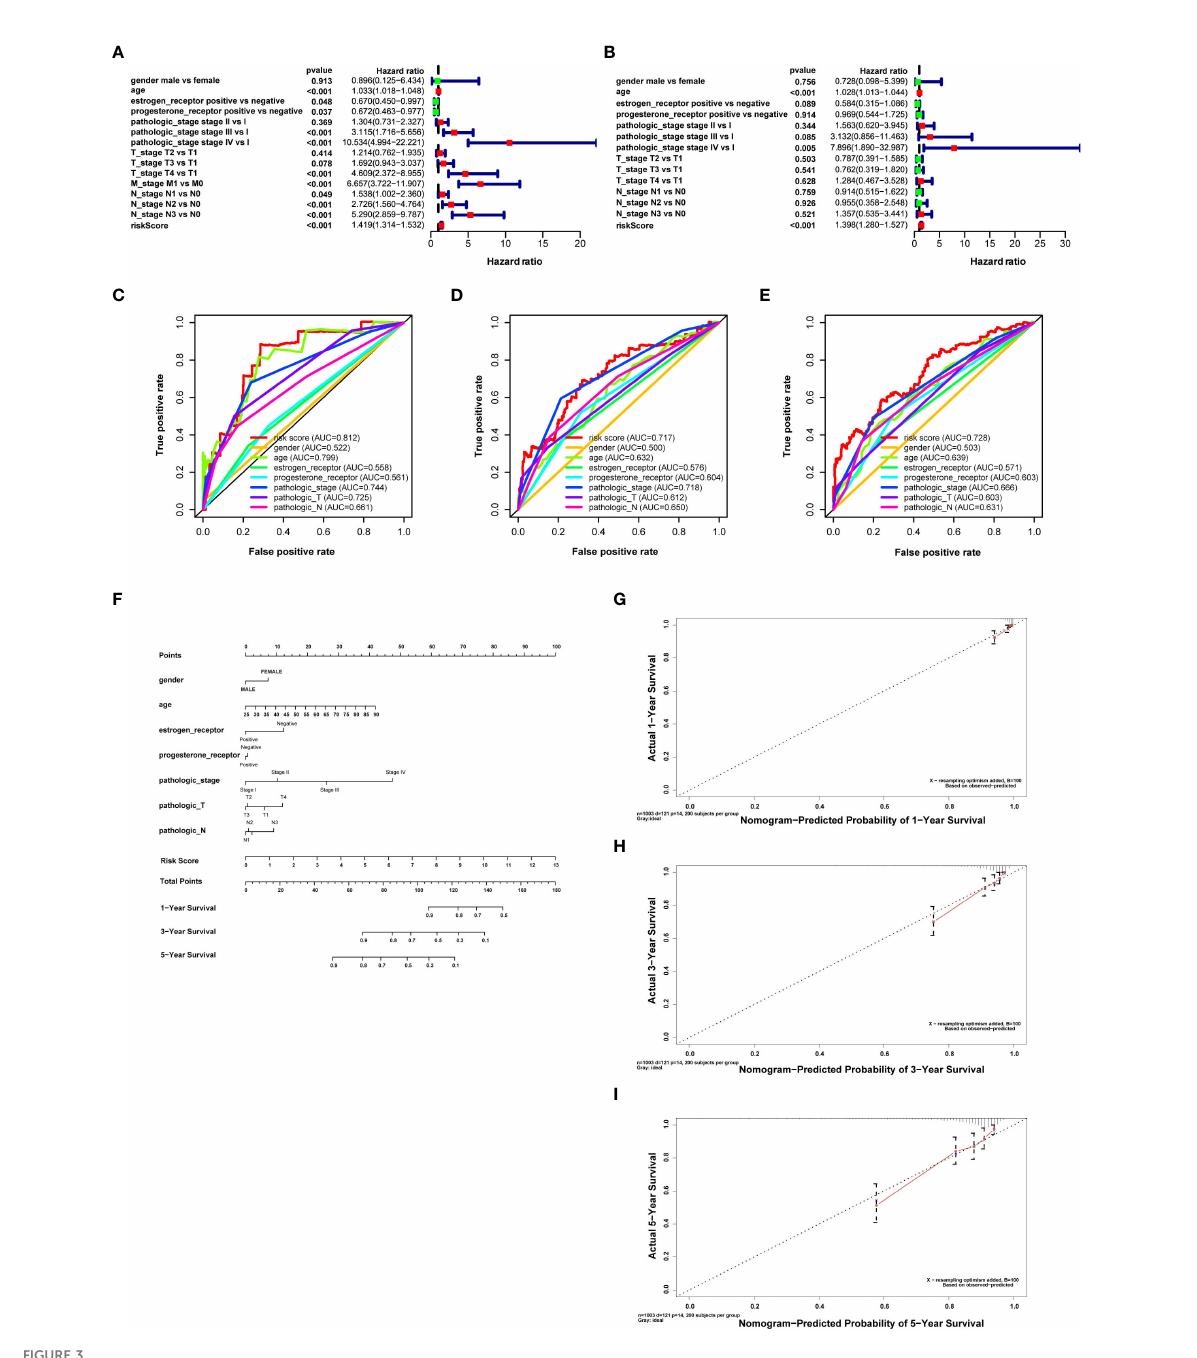
FIGURE 3 Retrieving survival indicators, evaluating their discrimination, and constructing a prognostic nomogram. (A) Forest plot for risk score and clinical features in the univariate Cox proportional risk regression model. (B) Forest plot for risk score and clinical features in the multivariate Cox proportional risk regression model. (C) Receiver operating characteristic (ROC) curves for evaluating the discrimination of survival indicators in 1 year. (D) ROC curves to evaluate the discrimination of survival indicators in 3 years. (E) ROC curves for evaluating the discrimination of survival indicators in 5 years. The risk score has better prognosis discrimination feasibility than other clinical features; the discrimination feasibility increased with the ascending of AUC. (F) Nomogram for breast cancer with gender, age, clinical stage, T and N stages, estrogen receptor, progesterone receptor, and risk score calculated by prognosis-related DNA repair genes predicting survival in 1, 3, and 5 years. (G) Calibration curves of the prognostic nomogram prediction in 1 year. (H) Calibration curves of the prognostic nomogram prediction in 3 years. (I) Calibration curves of the prognostic nomogram prediction in 5